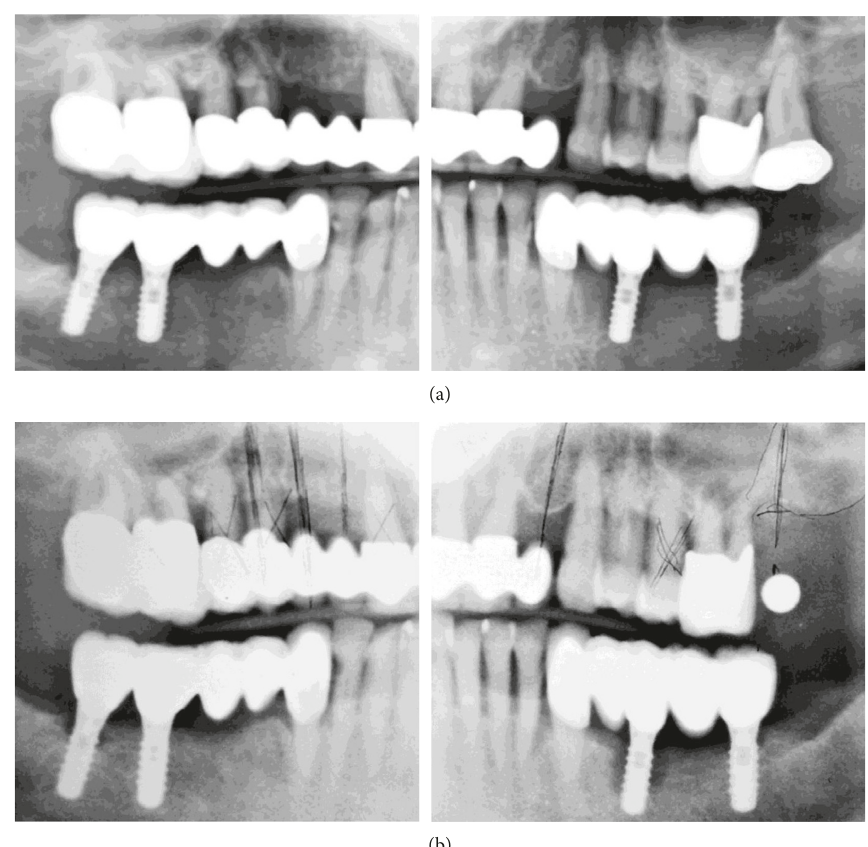
Figure 2: OPGs (original OPG of previous treatment modified for presentation reasons). (a) After mandibular implant loading (July 2004). (b) After extraction of tooth #15 (January